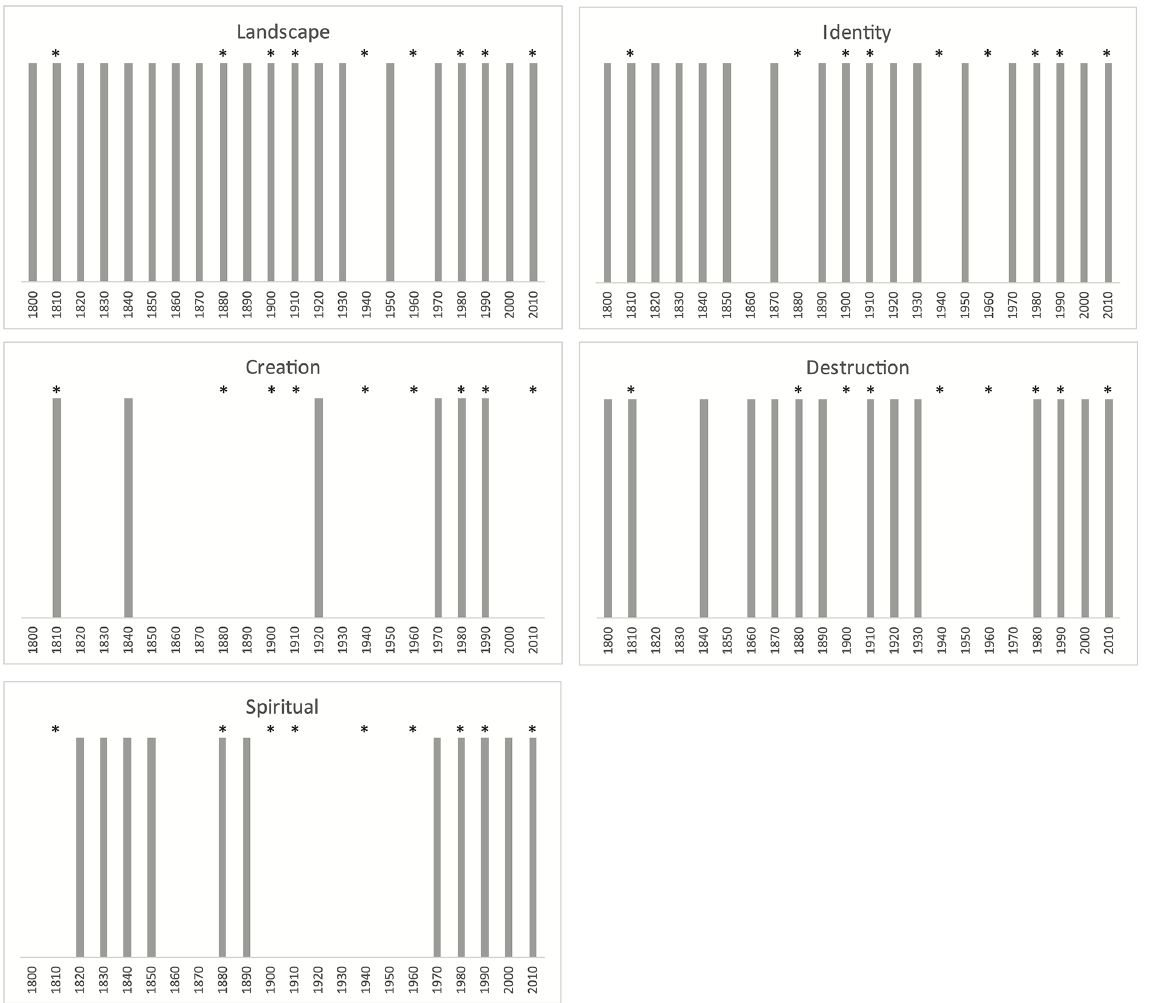
Figure 2. Emerging categories in the considered poems, arranged chronologically and aggregated by decade. Asterisks indicate major eruptions (as shown in Table